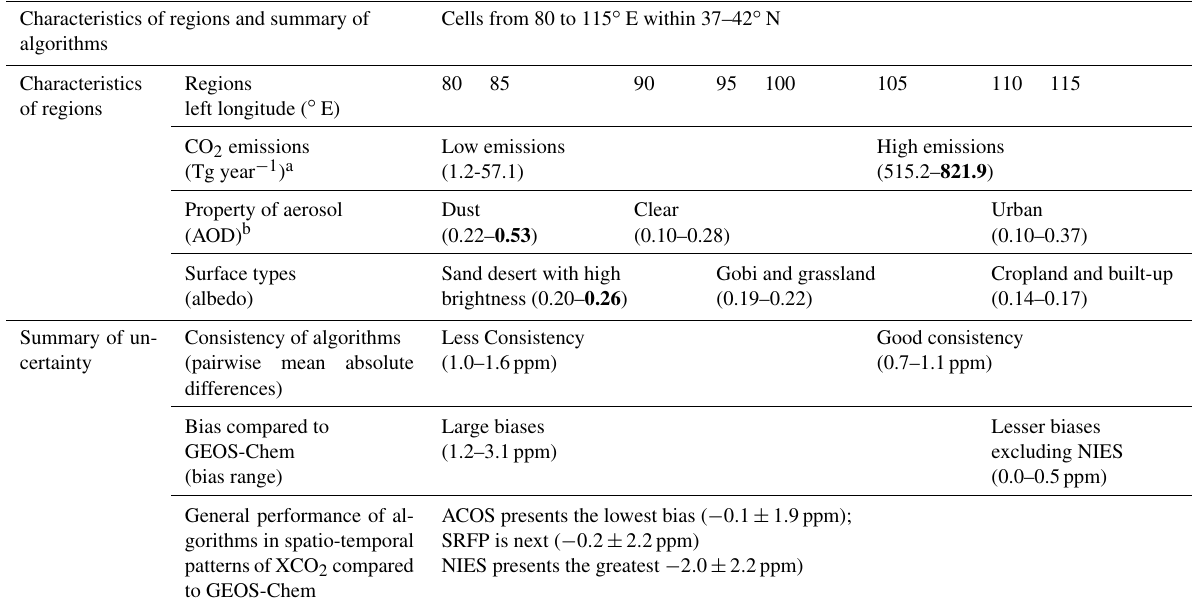
Table 7. Summaries of our analyses for uncertainty of XCO 2 retrievals obtained by GOSAT via inter-comparison of multi-algorithms above, including characteristics of regional emissions, albedo, aerosol optical depth and summary of differences between algorithms and bias compared to GEOS-Chem. Values reflecting typical regional characteristics are highlighted in